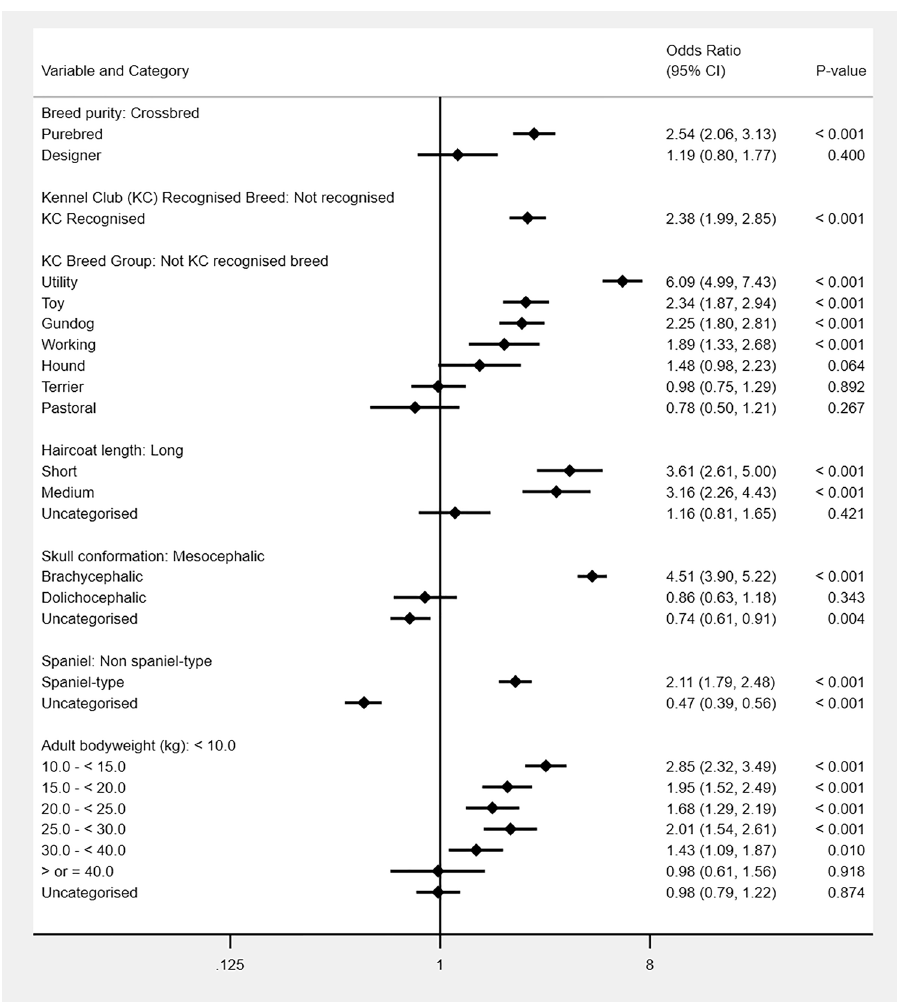
Figure 3. Results for risk factors that directly replaced the breed variable in the final breed-focused mixed effects multivariable logistic regression model (along with age, sex/neuter and insurance status). These results report associations between these risk factors and skin fold dermatitis in dogs under primary veterinary care in the VetCompass Programme in the UK. Clinic attended was included as a random effect. * CI confidence